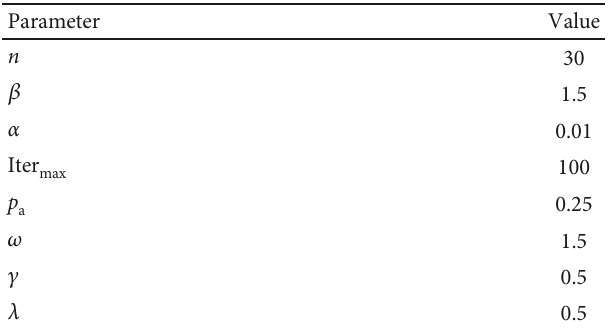
Table 4: Parameters of the ICSDC